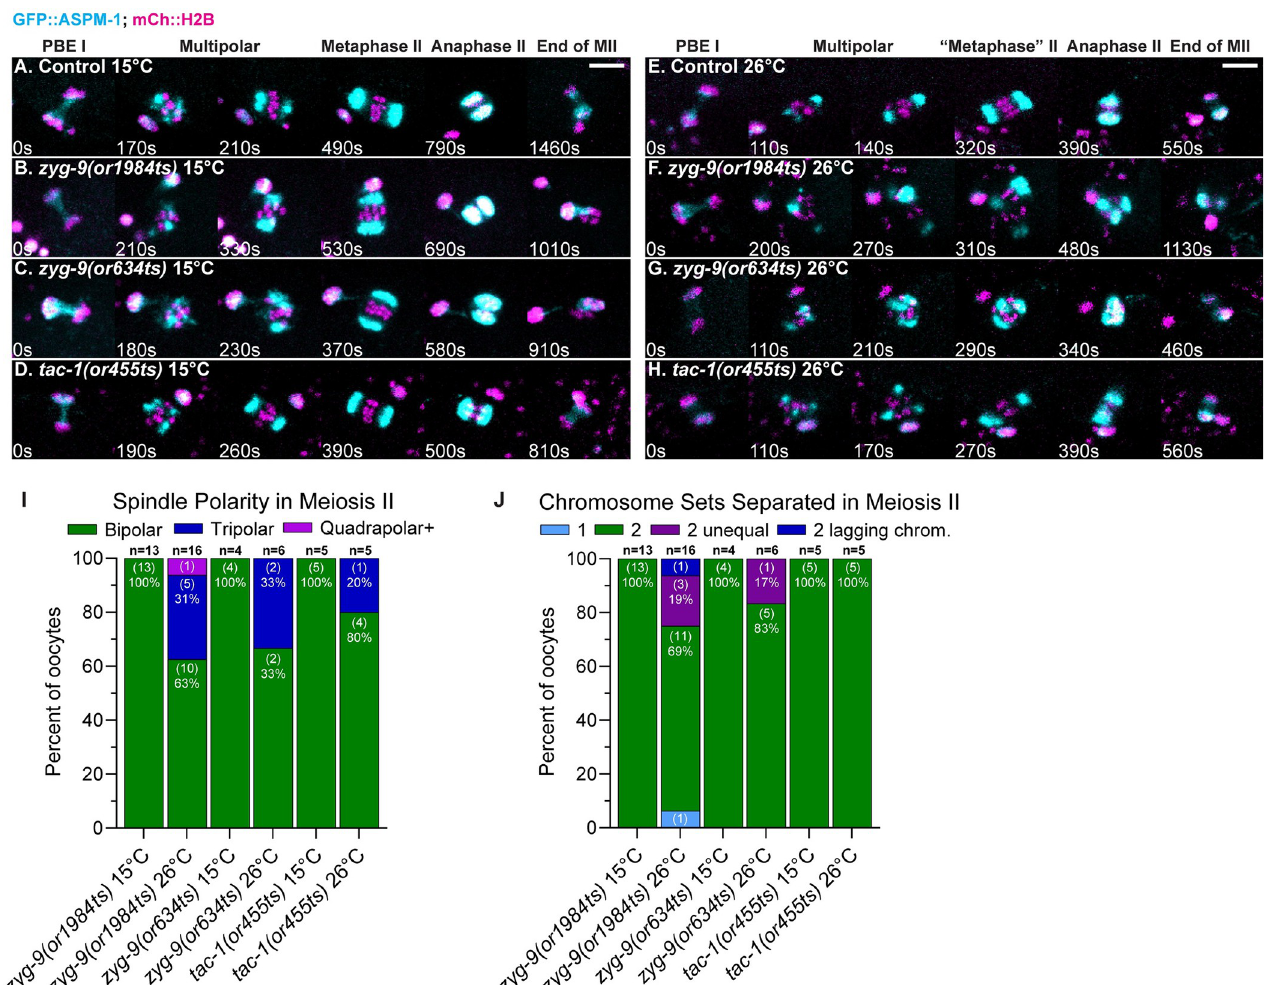
Fig 8. ZYG-9 and TAC-1 are required for meiosis II spindle assembly. (A-H) Time-lapse maximum intensity projection images during meiosis II of live control and TS mutant oocytes expressing GFP::ASPM-1 and mCherry::H2B at 15˚C (A-D) and at 26˚C (E-H). t = 0 is the timepoint when meiosis I chromosome separation ends. (I-J) Number of spindle poles present per oocyte at the onset of spindle shortening (I); of chromosome sets separated during anaphase II (J); number of oocytes examined indicated above each bar, number scored with each phenotype shown in parentheses inside bars with corresponding percent below. Scale bars = 5 μ